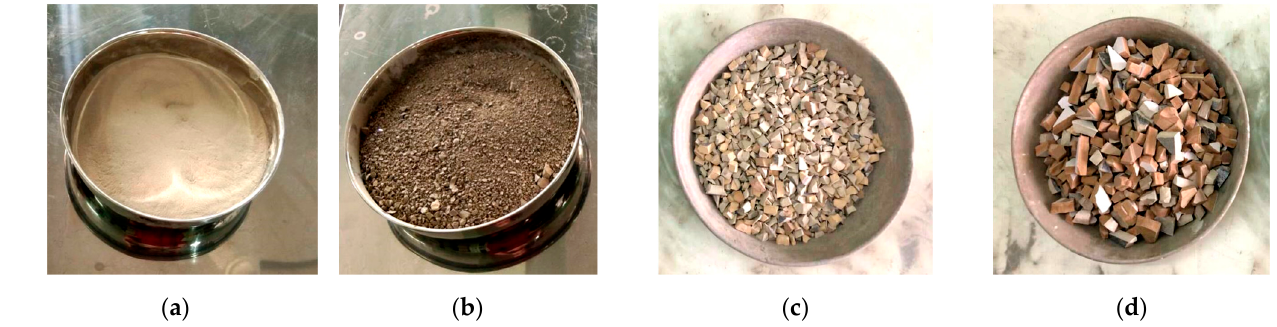
Figure 2. ( a ) Commercial cement; ( b ) river sand; ( c ) natural coarse aggregates (NCA)—10 mm; ( d ) natural coarse aggregates (NCA)—20 mm.